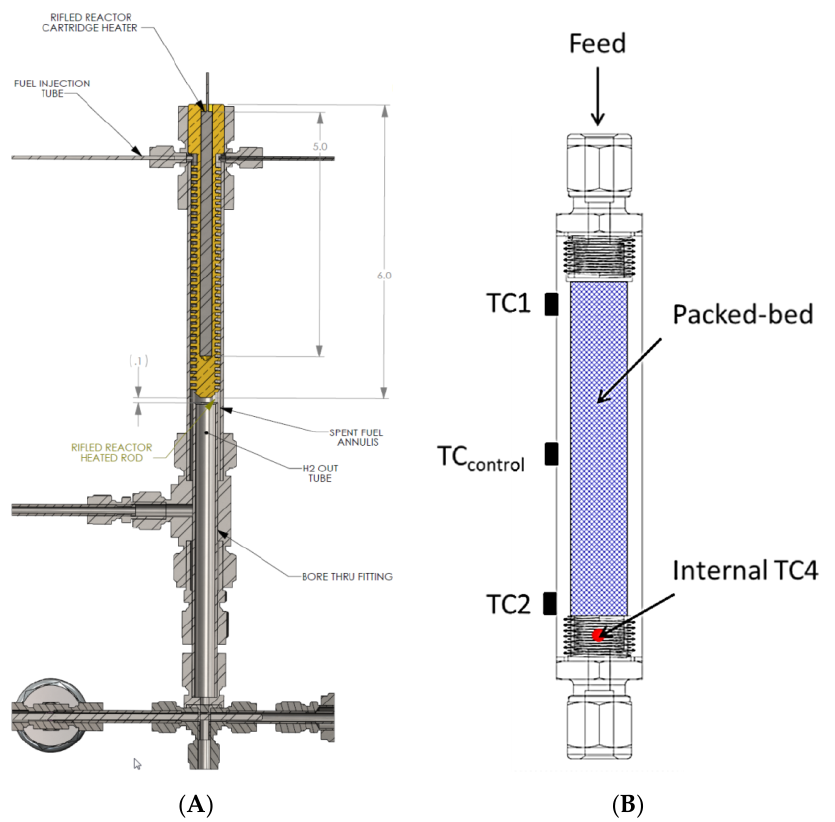
Figure 8. Helical ( A ) and packed-bed ( B ) reactors used for liquid-phase methoxy propyl amine borane hydrogen storage media. Note: TC denotes thermocouple.